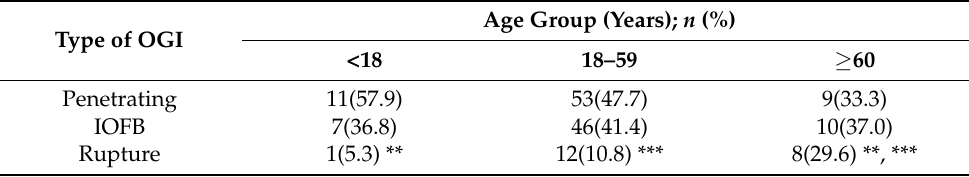
Table 1. Distribution by age and type of open globe injury (OGI).